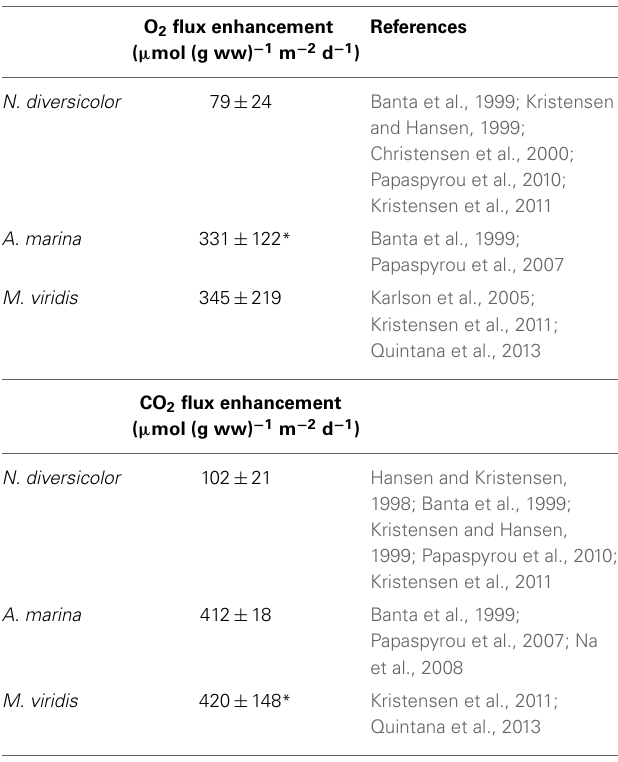
Table 4 | Literature values of weight-, area-, and time-specific conversion factors of flux enhancement by Nereis diversicolor , Arenicola marina , and Marenzelleria